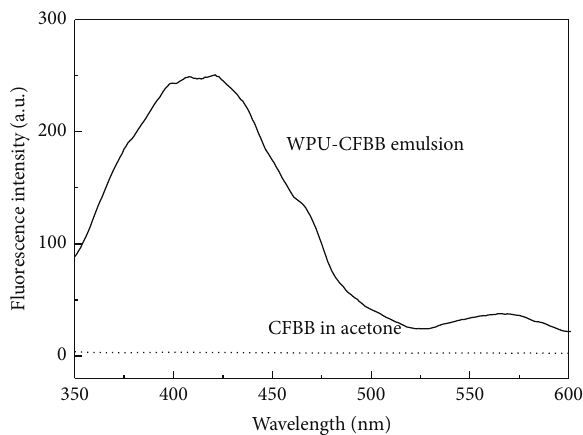
Figure 7: Fluorescence spectra of WPU-CFBB and CFBB in acetone under 325nm excitation.